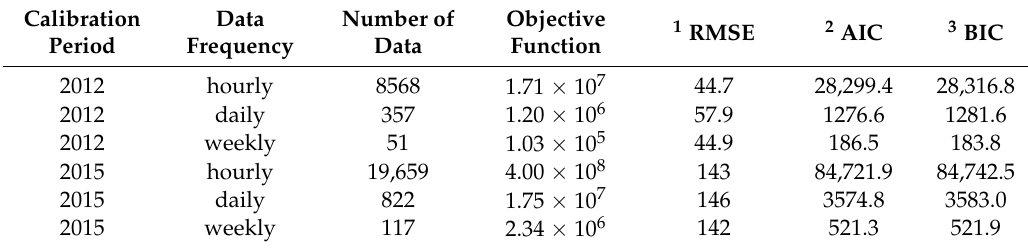
Table 4. Parameters characterizing the effectiveness of